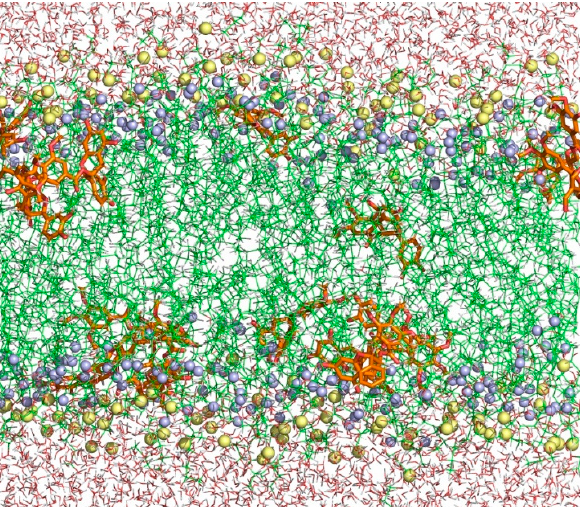
Figure 9. Final snapshot of the simulation box at 308 K of DMPG + TMBC. Water molecules are shown with purple lines, TMBC with orange and red sticks, DMPG with green lines, lipid carbonyl groups with blue spheres, and phosphorous atoms with yellow spheres.